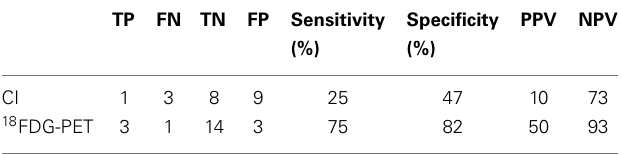
Table 3 | Overview of diagnostic values obtained for 18 FDG-PET and CI .